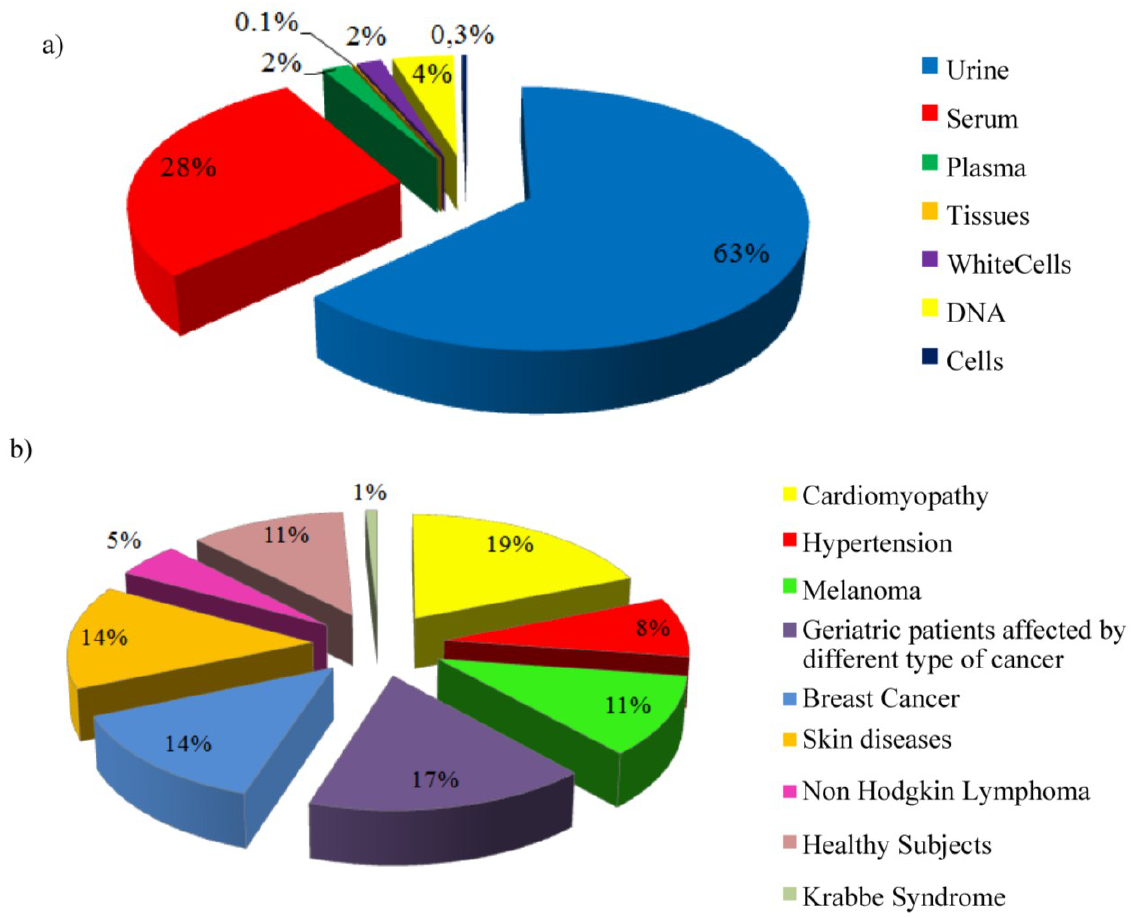
Figure 1. Percentage distribution of da Vinci European BioBank (daVEB) collections by ( a ) samples type and ( b ) pathology (healthy subjects